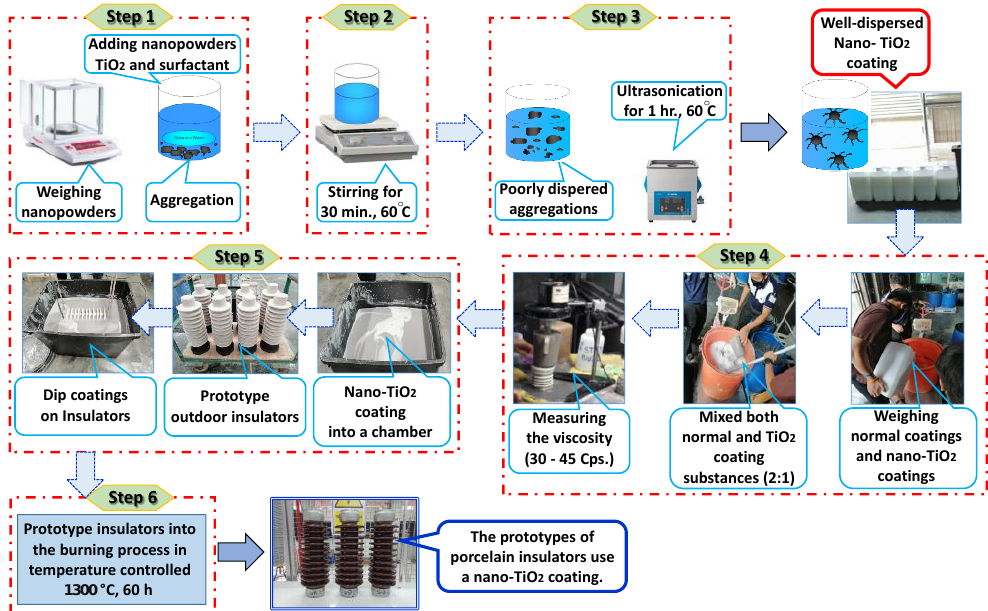
Figure 5. Preparation of nano-TiO 2 coating of outdoor insulators in this study.